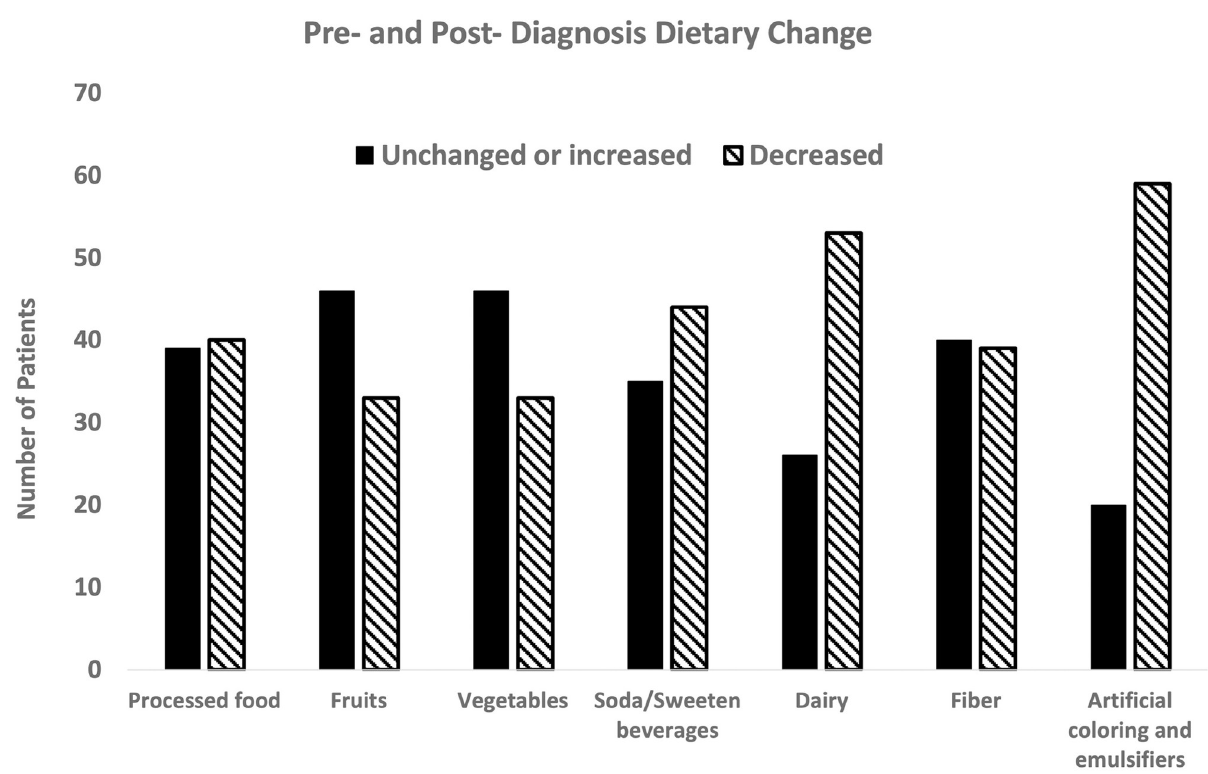
Fig 3. Pre- and post- diagnosis dietary changes. Post-diagnosis dietary patterns show a decrease in consumption of dairy, soft drinks, and foods with artificial coloring/emulsifiers when compared pre-diagnosis patterns. There is an increase in fruits and vegetable consumption post-diagnosis.